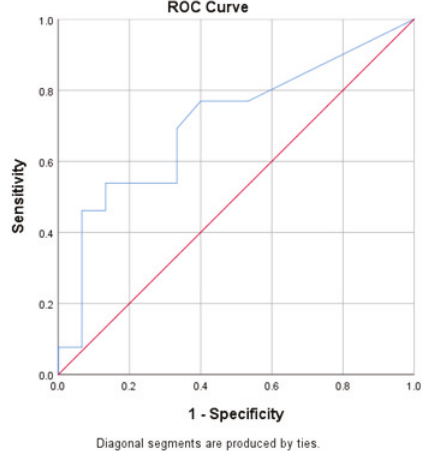
Figure 2. The ROC curve: uNGAL to predict the CrCl < 90 mL/1.73 m 2 /day on day 1 of PICU ad- mission.